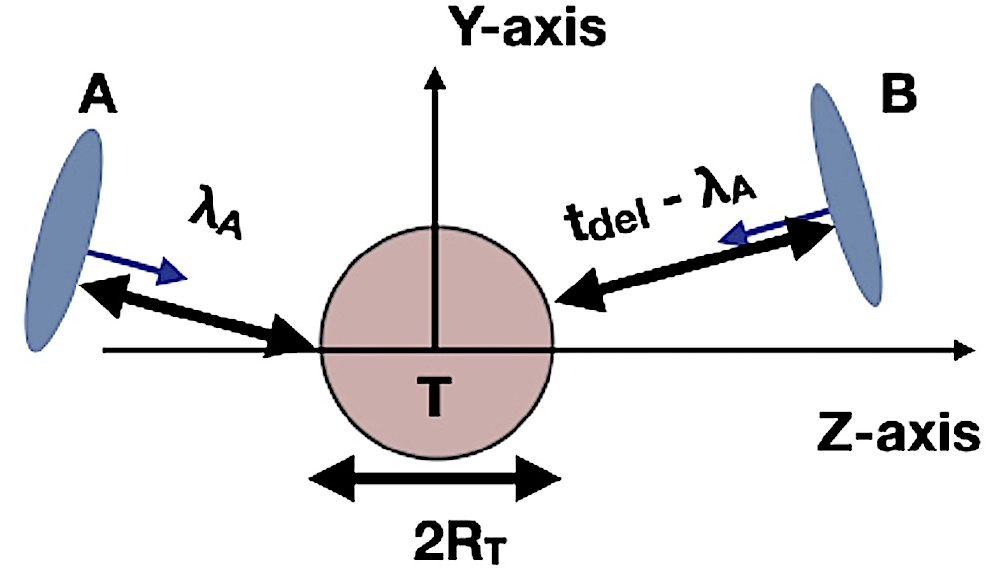
Figure A2. Scheme of the interaction process of two colliding nuclei A and B with the nucleus of the target T with the geometrical radii R A , R B and R T , respectively. The interaction volume V int T ∈ A + B is defined by the distance between the surfaces of nuclei A and B, which is 2 R T + t del , and by the maximal geometrical size of nuclei A and T. For such a configuration of nuclei, the TNC will occur with a probability equal to 1. The mean value for V int is provided by averaging over the distance T ∈ A + B λ A between the surfaces of a nucleus A and the target T. Similar averaging over the nucleus B position should be performed as